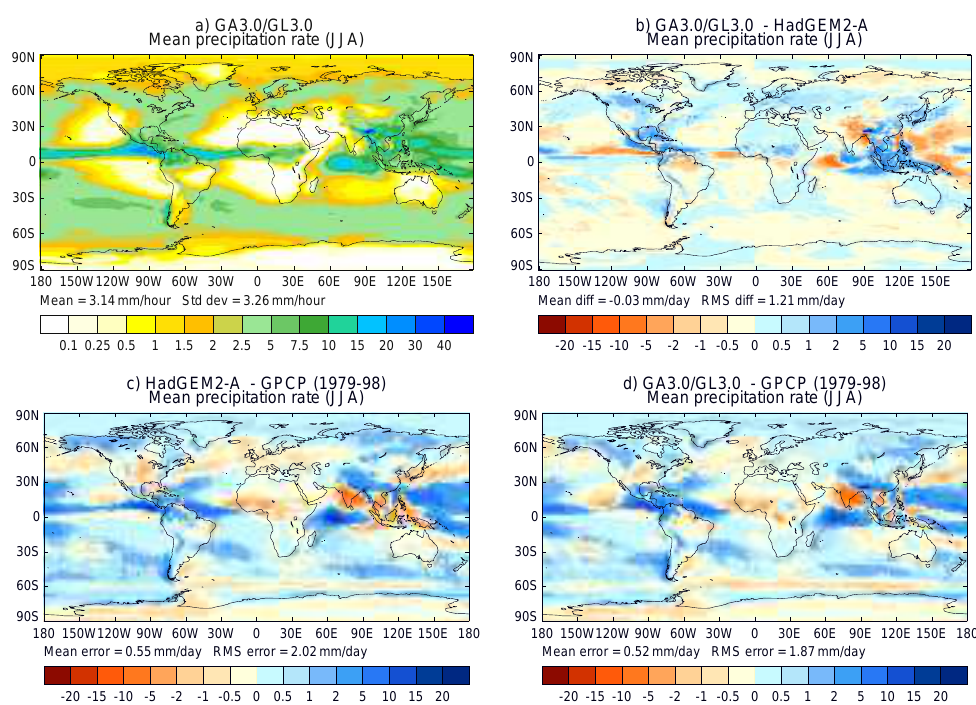
Fig. 5. Climatological precipitation during JJA in the 30 year N96 simulation using the same format as Fig. 3. Observations used are from GPCP (Adler et al., 2003).